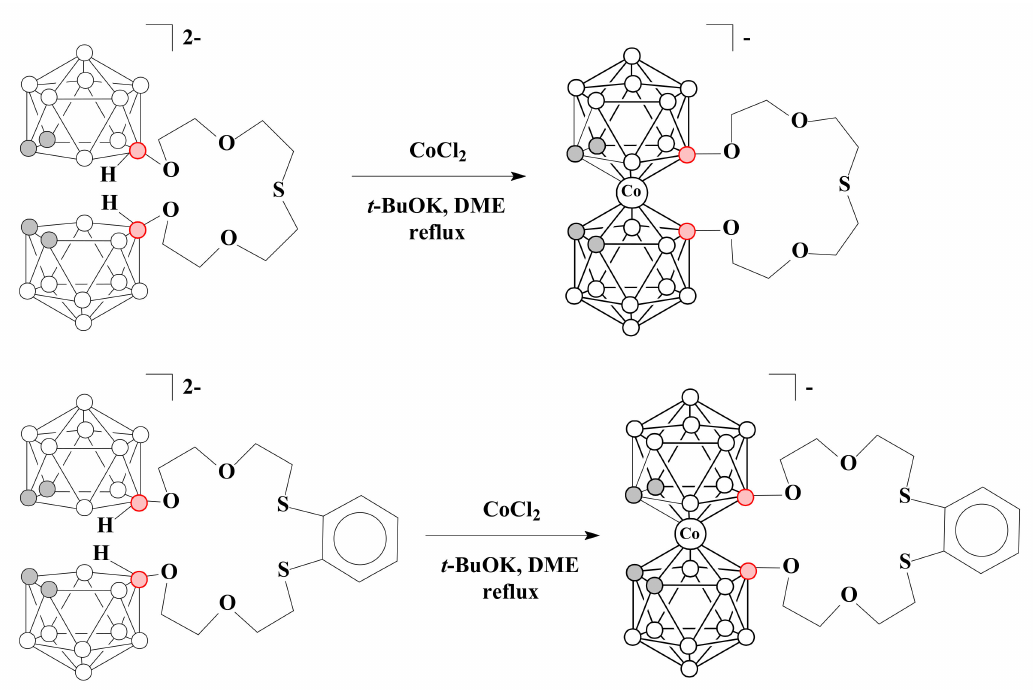
Scheme 11. Synthesis of crown ethers with the incorporated cobalt bis(dicarbollide) fragment. The crystal structure of sodium salt of [8,8 (cid:48) -(OCH 2 CH 2 OCH 2 CH 2 S) 2 - o -C 6 H 4 -3,3 (cid:48) - Co(1,2-C 2 B 9 H 9 ) 2 ] − , which was obtained during the drying of the solution of parent potas- sium salt in diethyl ether over Na 2 SO 4 , was determined by X-ray analysis [79] (Figure 3).